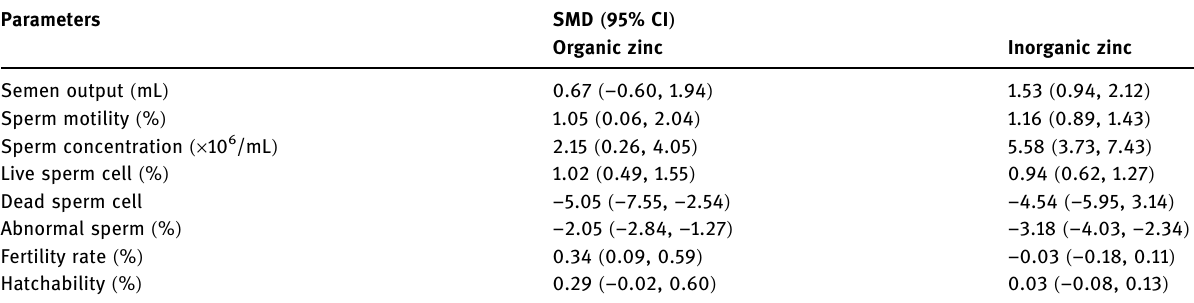
Table 2: E ff ect of zinc source on reproductive markers in breeder chickens Parameters SMD ( 95% CI )